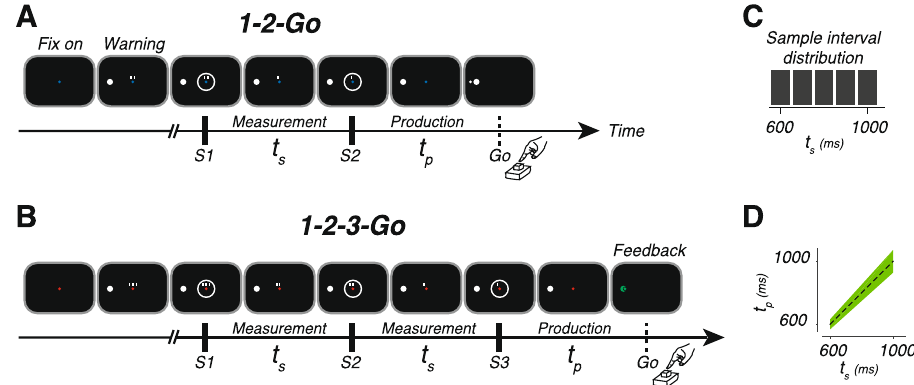
Figure 1. The 1-2-Go and 1-2-3-Go interval reproduction task. ( A , B ) Task design. Each trial began with the appearance of a fixation spot (Fix on). The color of the fixation spot informed the subject of the trial type: blue for 1-2-Go, and red for 1-2-3-Go. After a random delay, a warning stimulus (large white circle) appeared. Additionally, two or three small white rectangles were presented above the fixation spot. The number of rectangles was associated with the number of upcoming flashes. After another random delay, two (S1 and S2 for 1-2-Go) or three (S1, S2 and S3 for 1-2-3-Go) white annulae were flashed for 100 ms in a sequence around the fixation spot. Consecutive flashes were separated by the duration of the sample interval ( t s ). With the disappearance of each flash, one of the small rectangles also disappeared (rightmost first and leftmost last). The white rectangles were provided to help subjects keep track of events during the trial. Subjects had to press a button after the last flash to produce an interval ( t p ) that matched t s . Immediately after button press, subjects received feedback. The feedback was a small circle that was presented to the left or right of the warning stimulus depending on whether t p was larger or smaller than t s , respectively. The distance of the feedback circle to the center of the warning stimulus was proportional to the magnitude of the error ( t p − t s ). ( C ) Experimental distribution of sample intervals. ( D ) Feedback. Subjects received positive feedback if production times fell within the green region. The width of the positive feedback window was scaled with t s